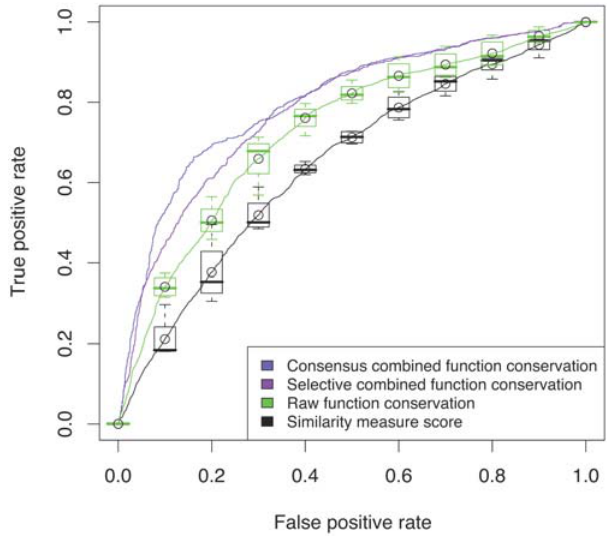
Figure 6. On Experimental Annotation Data Only. Comparing similarity scores to raw and combined function conservation scores. ROC analysis on a reduced high quality data set containing only experimental annotation data (evidence codes IDA, IEP, IGI, IMP, IPI) for 629 proteins. The black curve displays the average ROC curve for the four similarity measures (CE, TM, LP, GP); the boxplots are an estimate of the observed spread. The green curve corresponds to the average of the four raw function conservation scores. The ROC performance of selective and consensus combination is shown with the violet and blue curves, selected such that at least one of their annotated GO terms was predictable by the PHUNCTIONER method. We have repeated this evaluation procedure in an analogous fashion on the set of 3449 protein domains also employed in our other experiments. The resulting ROC curves for the GOdot method are shown in Figure 7. The two GOdot predictors, using selective and consensus combination of scores, are compared to a baseline reference